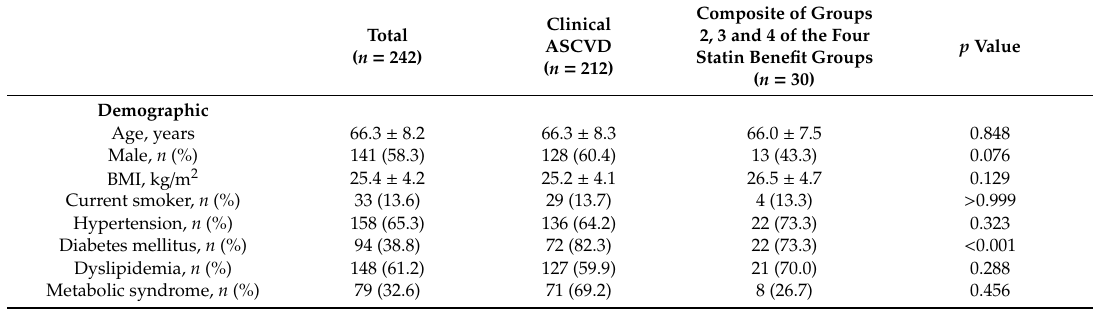
Table 1. Baseline characteristics as per The American College of Cardiology and American Heart Association (ACC / AHA) guidelines of the four statin benefit groups, by clinical atherosclerotic cardiovascular disease